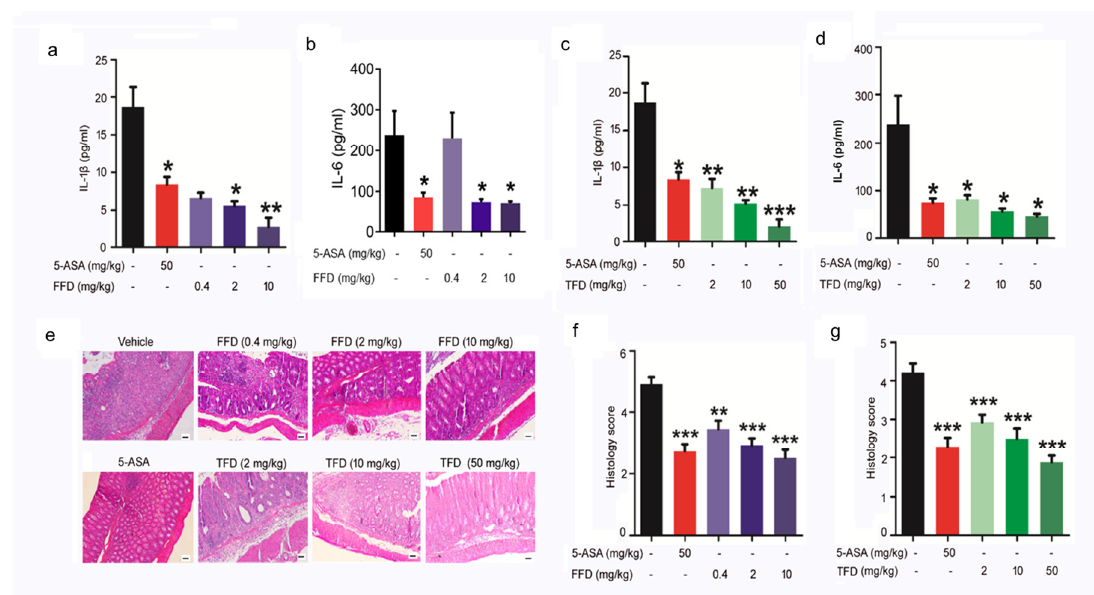
Figure 2. Inflammatory response of Fexofenadine (FFD)-treated or Terfenadine (TFD)-treated, or controls in DSS model mice. a-d. Serum levels of IL-1 β and IL-6. ( a ) Serum level of IL-1 β in ctrl, or 5-ASA or FFD-treated group. ( b ) Serum level of IL-6 in ctrl, or 5-ASA or FFD-treated group. ( c ) Serum level of IL-1 β in ctrl, or 5-ASA or TFD-treated group. ( d ) Serum level of IL-6 in ctrl, or 5-ASA or TFD-treated group. ( e – g ) H&E staining and its quantitative analysis in colon tissue sections in ctrl or 5-ASA, or FFD, or TFD-treated group. Statistical analysis was done to compare the treatment groups and vehicle groups. n = 6 per group. Data are mean ± SE; * p < 0.05, ** p < 0.01, *** p < 0.001. (Scale bar, 100 µ m).